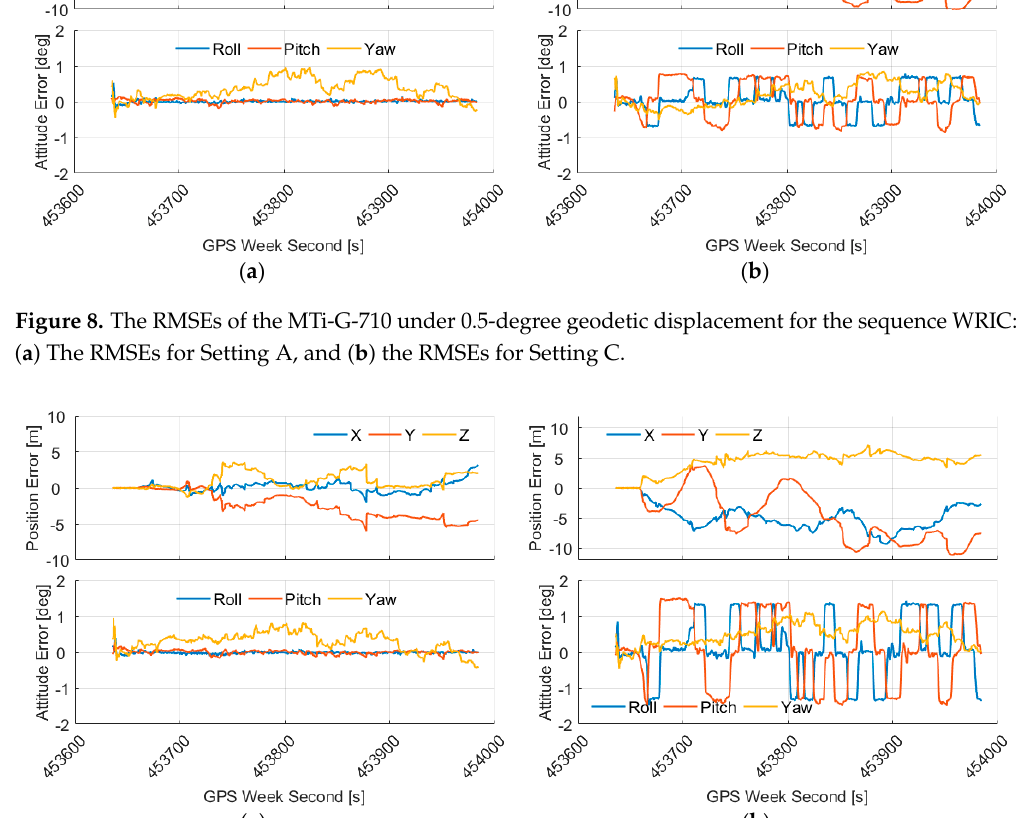
Figure 9. The RMSEs of the MTi-G-710 under 1.0-degree geodetic displacement for the sequence WRIC: ( a ) The RMSEs for Setting A, and ( b ) the RMSEs for Setting C.